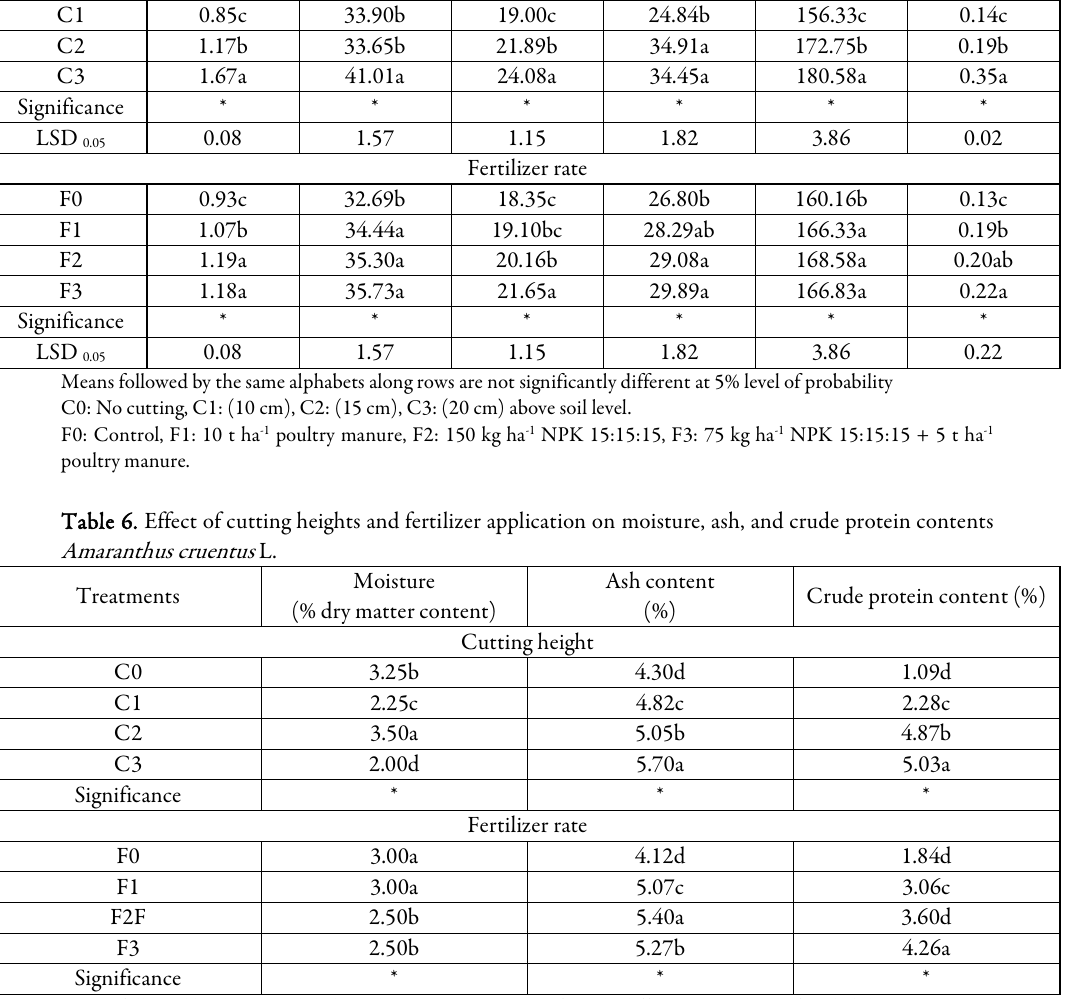
Table 5. Effect of cutting heights and fertilizer applications of nutrient uptake of Amaranthus cruentus L. Treatments